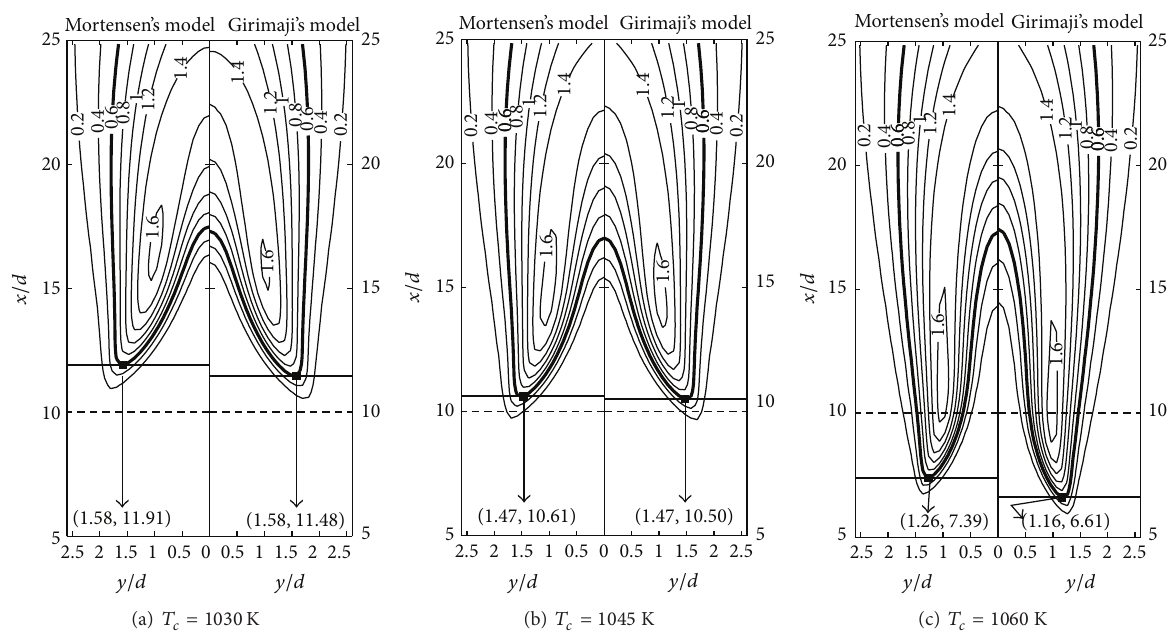
̃𝑌 (×10 3 ) : (a) 𝑇 = 1030 K, (b) 𝑇 = 1045 K, and (c) 𝑇 = 1060 K obtained using Mortensen’s model (left pane) and Figure 5: Contours of 𝑐 𝑐 𝑐 OH Girimaji’s model (right pane). The thick contour corresponds to 600 ppm. The solid and dashed horizontal lines correspond to the numerical and experimental liftoff heights,